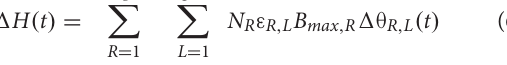
Frontiers in Physiology |